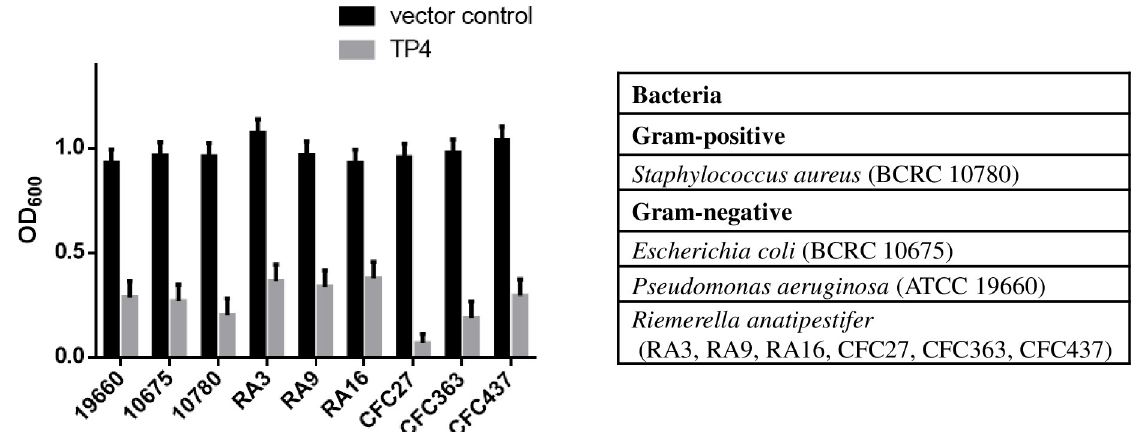
Fig 2. The effects of rTP4 on gram-negative and gram-positive strains by coincubation assay. After incubation, the culture medium was measured at a wavelength of 600 nm. A low OD 600 value indicates that bacterial growth was inhibited. Vector control: Empty pPICZ α A vector. TP4: Protein expressed by the pPICZ α A-TP4